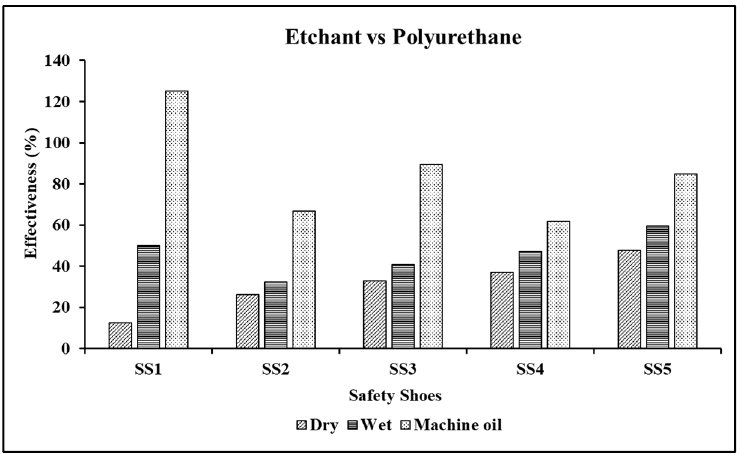
Figure 12. Effectiveness improvement of polyurethane-based coating as compared to etchant-based flooring across dry, wet, and machine oil contaminant conditions.